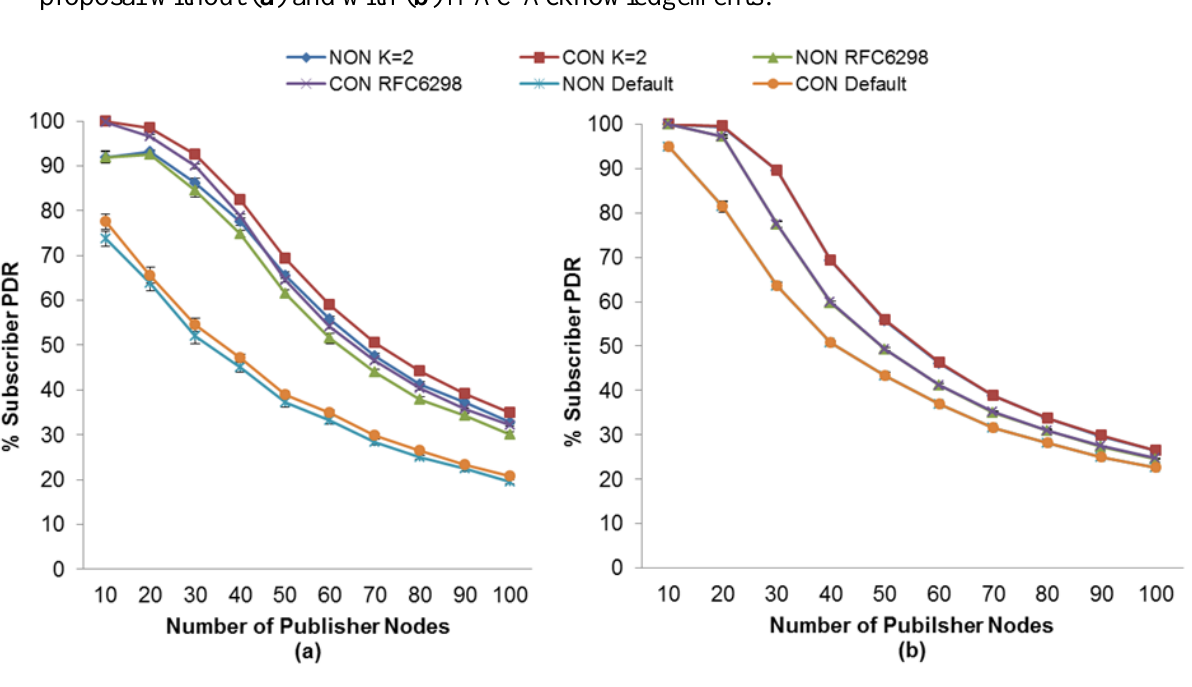
Figure 7. PDR comparisons between the RTO method of CoAP calculation and our proposal without ( a ) and with ( b ) MAC